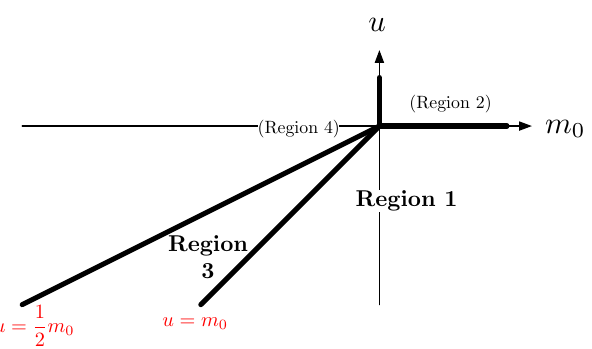
Figure 3. The phase diagram of the E 1 theory. The line between the Region 1 and the Region 3 is u = m 0 . The boundary of the physical parameter space is given by u = 1 u = 0 for m 0 (cid:21)